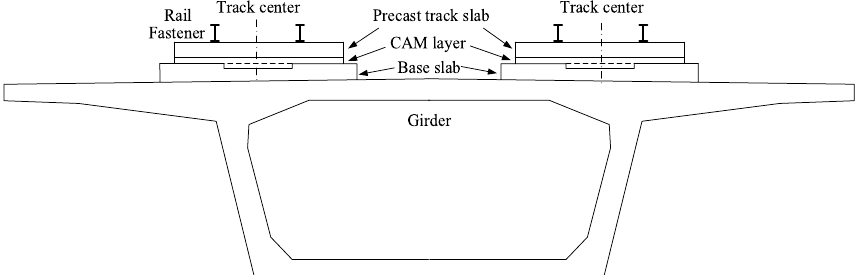
Fig. 8 Cross-section of the double-track railway bridge